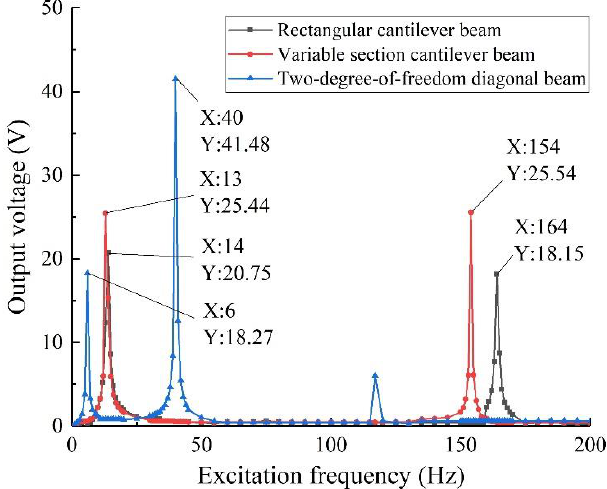
Figure 3. Output performance analysis of different beam structures.